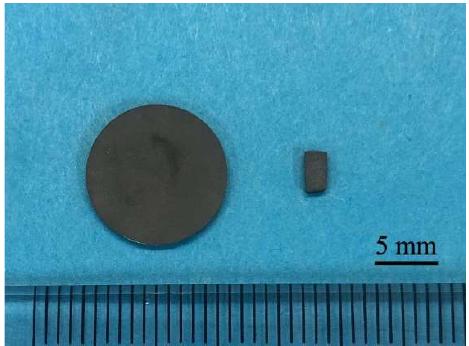
Figure 1. The picture of titanium disk and rectangular plate.